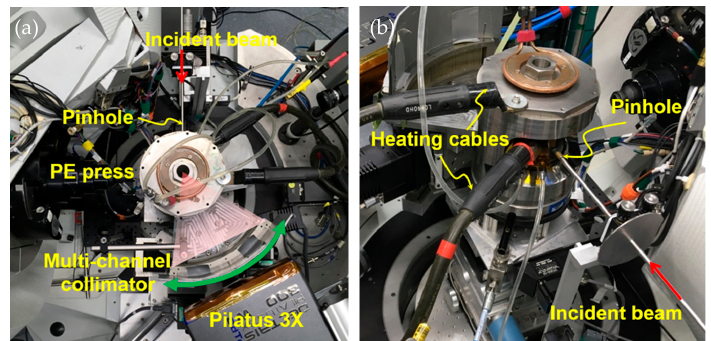
Figure 2. A general-purpose di ff ractometer is used for glass and liquid structure studies in 13-ID-C. ( a ) is a bird’s-eye view of the experimental setup. The incident beam enters the press from the top of the image, the general-purpose di ff ractometer carries a Pilatus3 X CdTe 300K-W pixel array detector, and the detector arm is capable of rotating with respect to two axes with an angular accuracy of 0.002 ◦ . This allows convenient alignment of the setup relative to the focused X-ray beam and large Q coverage. The multi-channel collimator is aligned with respect to the incident X-ray beam, with the experimental setup with the heating cables and water-cooling hoses attached and the 40 µ m wide pin hole projecting into the Paris-Edinburgh